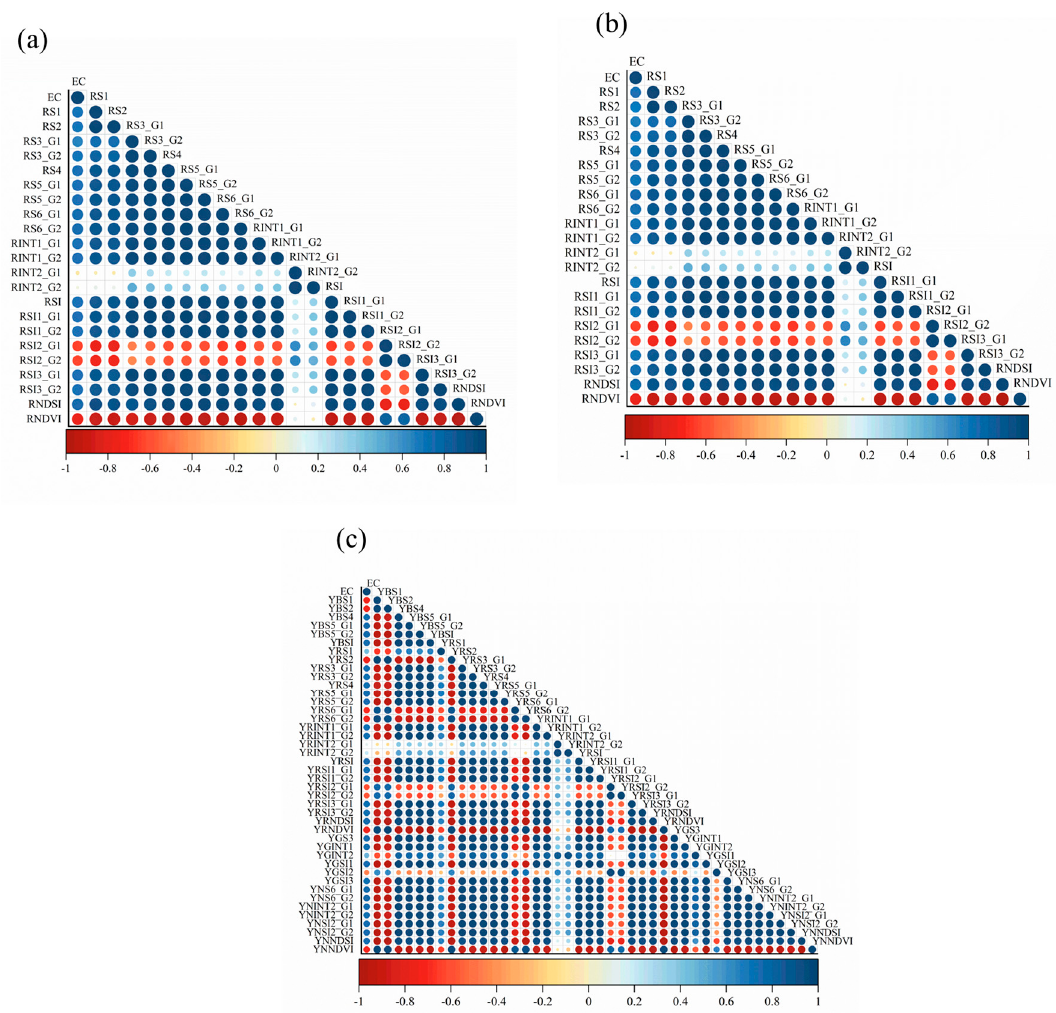
Figure 4. Relevance of the correlation between electrical conductivity (EC) and different soil salinity indices. ( a ) shows the Pearson correlation between the original salinity index and soil salinity. ( b ) shows the Pearson correlation between the new red-edge salinity index and soil salinity, and ( c ) shows the Pearson correlation between the new yellow-edge salinity index and soil salinity.